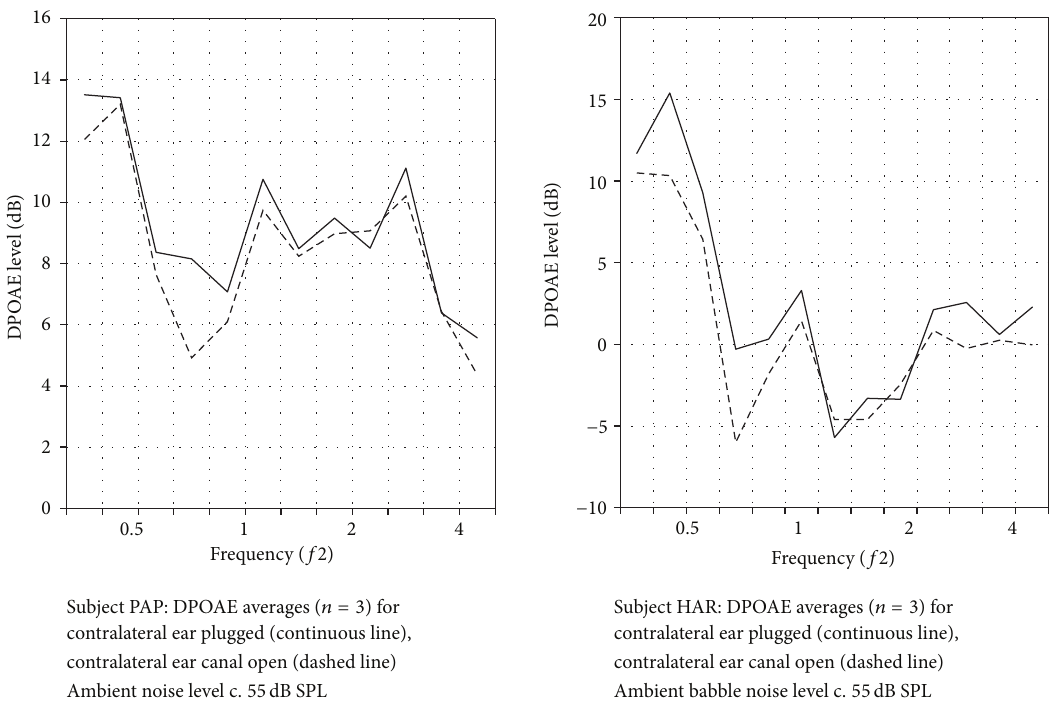
Figure 3: Example DPOAE ( 2𝑓1 - 𝑓2 ) versus frequency ( 𝑓2 ) plots, DPgrams, for two subjects measured with (solid lines) and without (dashed curves) contralateral ear canal occlusion. Measurements were made in an environment with an ambient noise level of 55 dB SPL. DP grams shown are an average of three sequential recordings.